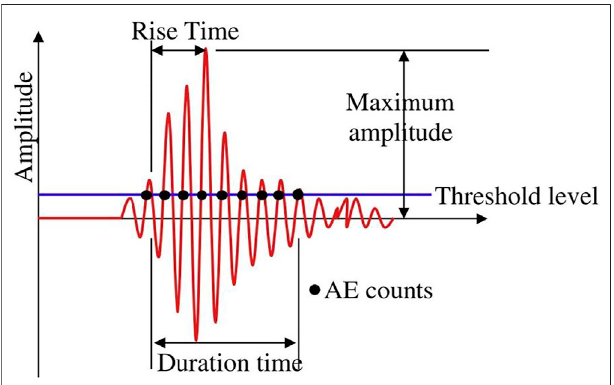
FIGURE 10 | AE parameters in an AE hit (Ohno K.,